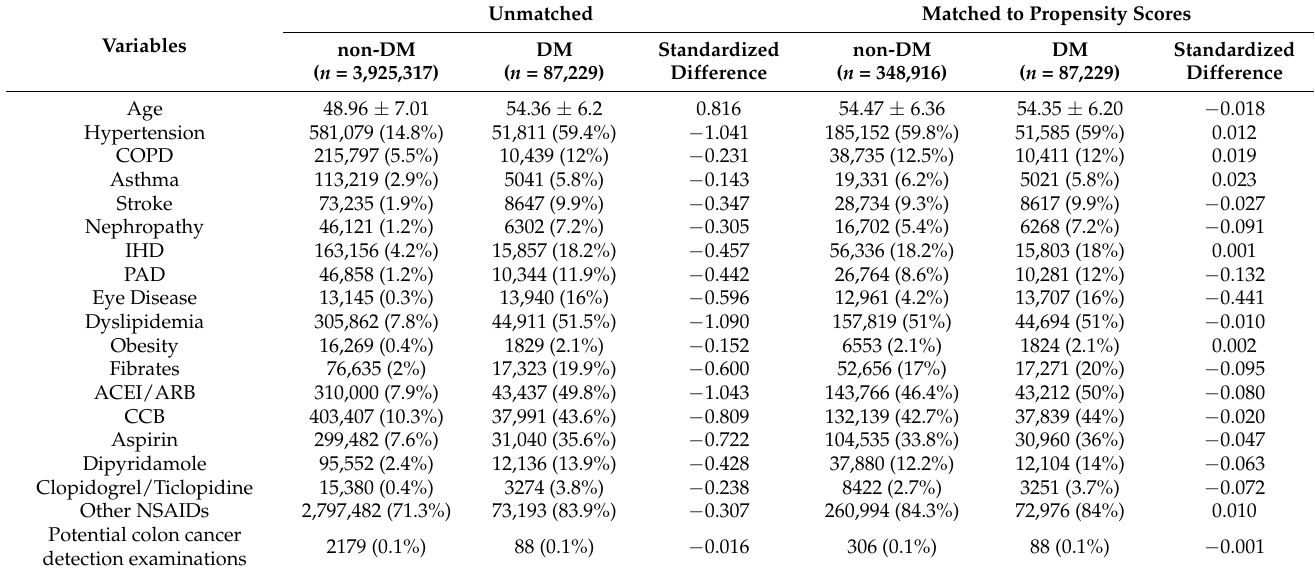
Table 1. Baseline characteristics of female patients aged 40–64 years with and without diabetes